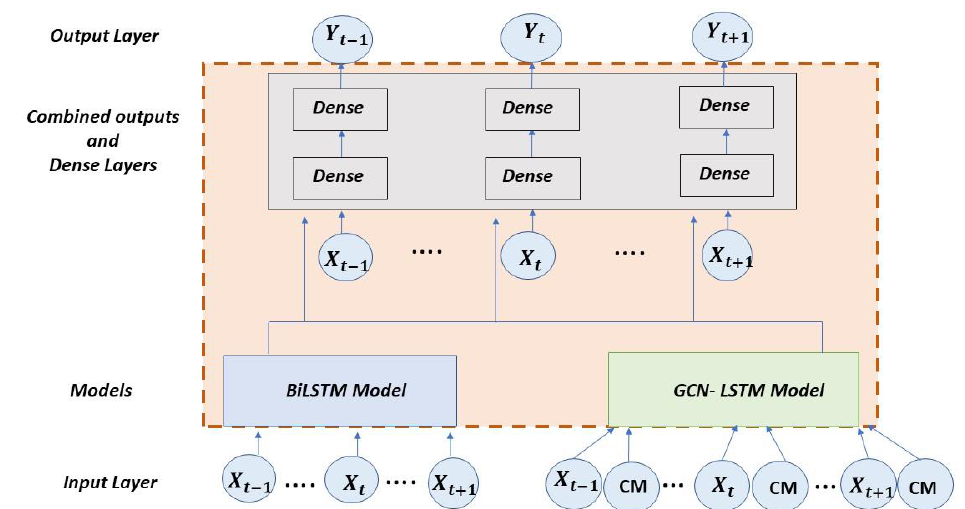
Figure 4. Combination of the BiLSTM and GCN-LSTM Models.